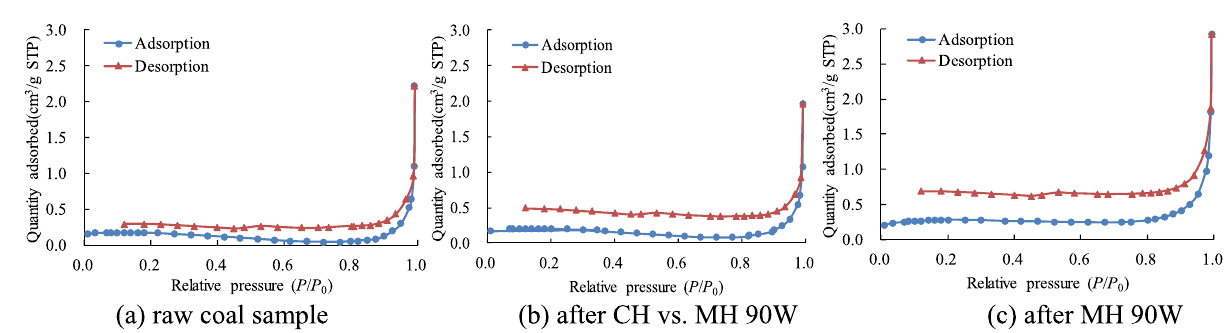
Figure 12. Adsorption/desorption isotherms for a sample of raw coal, a coal sample after CH vs. MH 90 W, and a coal sample after MH 90